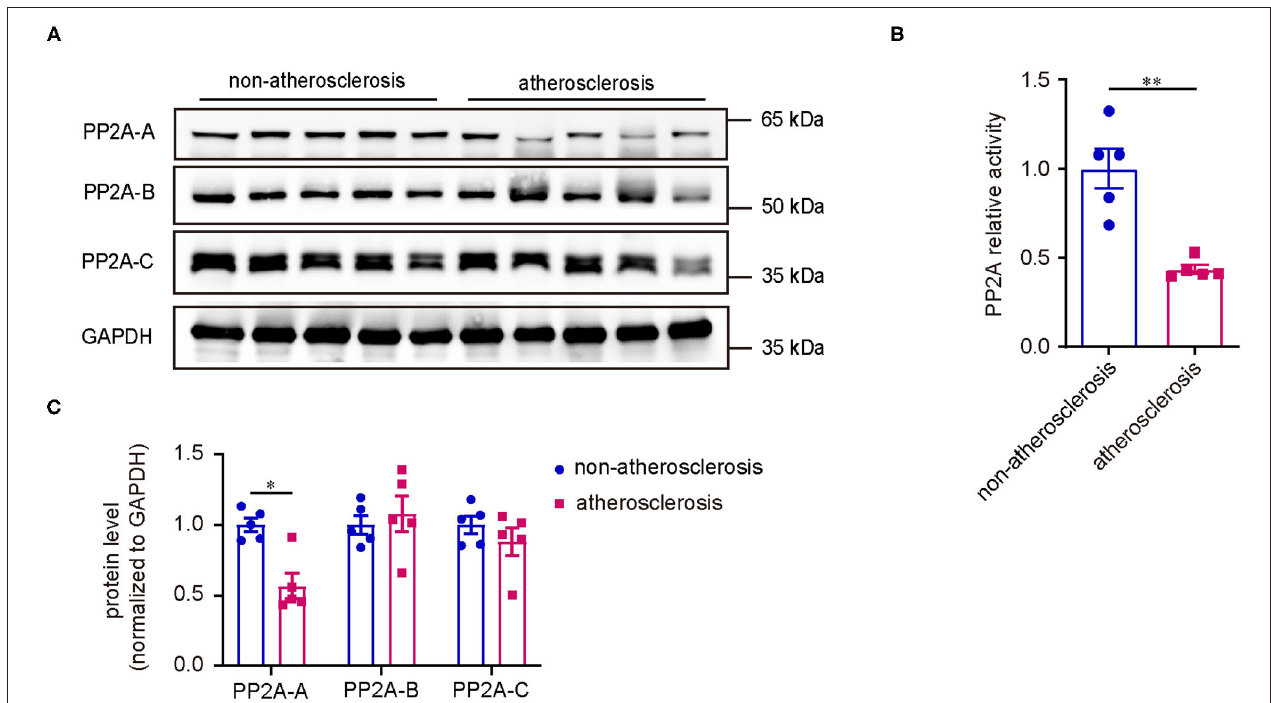
FIGURE 1 | Decreased PP2A expression and activity in human coronary atherosclerosis. (A) Upper panel: western blot assessment of PP2A subunits ( n = 5). Lower panel: western blot quantification. (B) PP2A activity assay in the same set of specimens as in (A) .